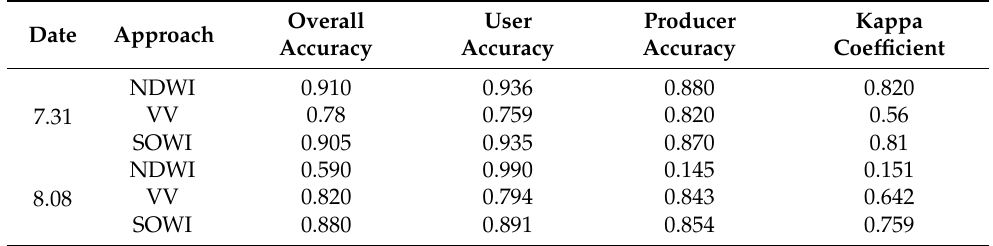
Table 3. Summary of accuracy assessments for different dates in the case area, including various accuracy